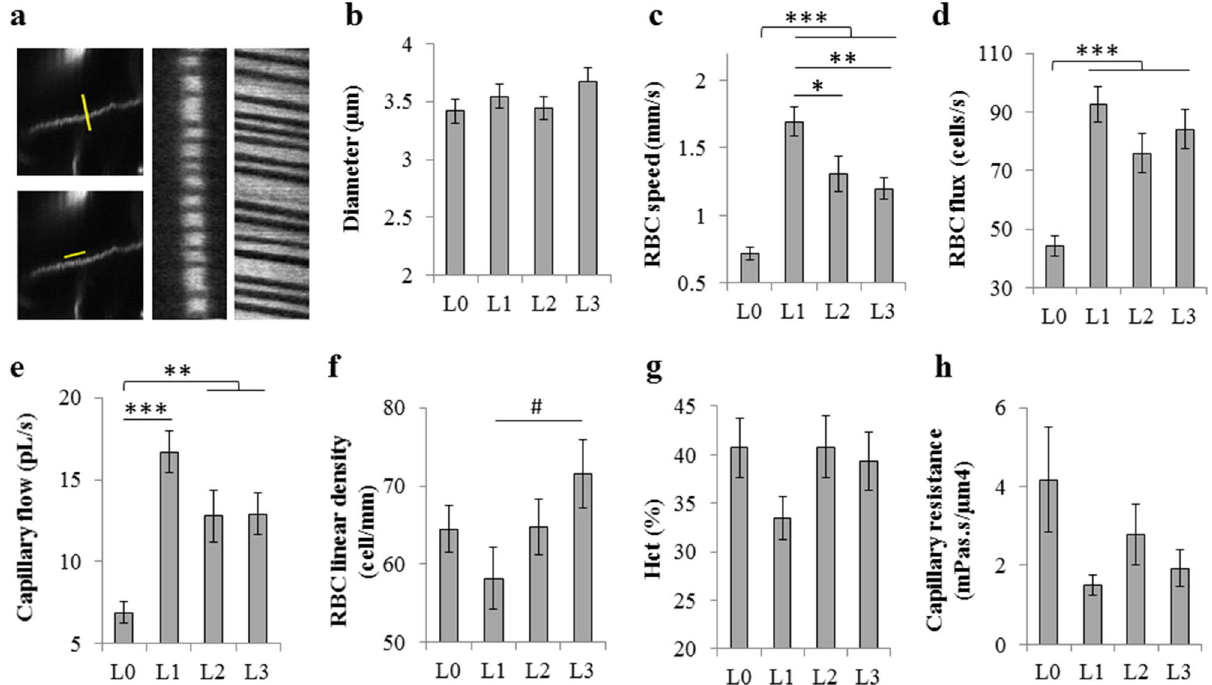
Figure 2. Capillary blood flow. (a) Perpendicular (upper left) and longitudinal (lower left) scans over selected capillaries and obtained space–time image (middle: perpendicular scan; right: longitudinal scan), from which capillary flow parameters were calculated. ( b – h ) Capillary diameter ( b ), RBC speed ( c ) and RBC flux ( d ) were obtained from space–time images. Capillary volumetric flow ( e ), RBC linear density ( f ), capillary hematocrit ( g ) and capillary resistance ( h ) were estimated from diameter, flux and speed. (L0, n = 39; L1, n = 25; L2, n = 30; L3, n = 32 capillaries). L0: rest, L1: exercise level 1 (5 m/min), L2: exercise level 2 (10 m/min), L3: exercise level 3 (15 m/min). Results are presented as mean ± s.e.m. Statistical significance was calculated using ANOVA followed by Tukey HSD post hoc test. ***p < 0.001, **p < 0.01, *p < 0.05, #p-value approaches significance (p <